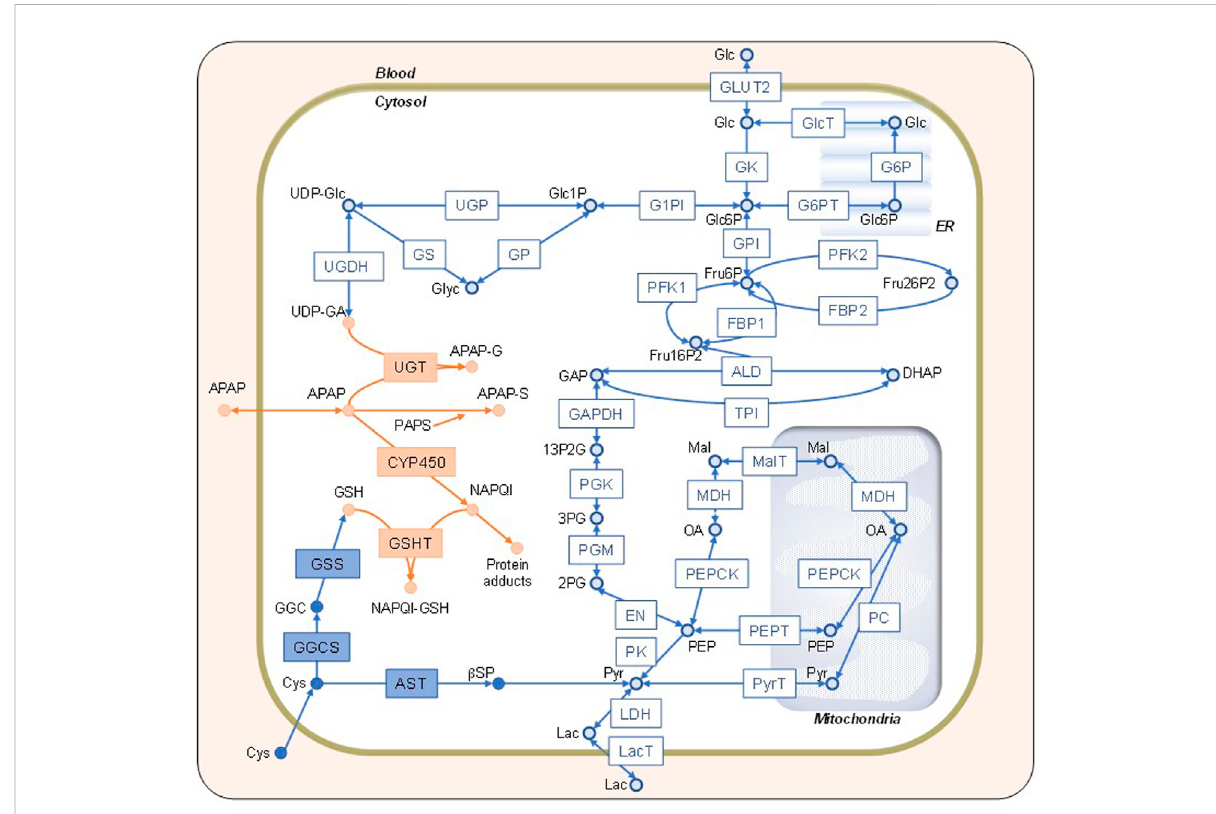
FIGURE 1 Network map of the constructed model. Schematic representation of the simulation model combining glucose (Glc), acetaminophen (APAP), and cysteine (Cys) metabolisms indicated by open blue, solid orange, and solid blue shapes, respectively. The de fi nitions of the abbreviations are listed in the Supplementary Material. Glc, lactate, APAP, and Cys in the blood can be transported into the cytosol. The endoplasmic reticulum and mitochondria are shown on the background. The square boxes represent enzymes and transporters, whereas the circles represent substrates and